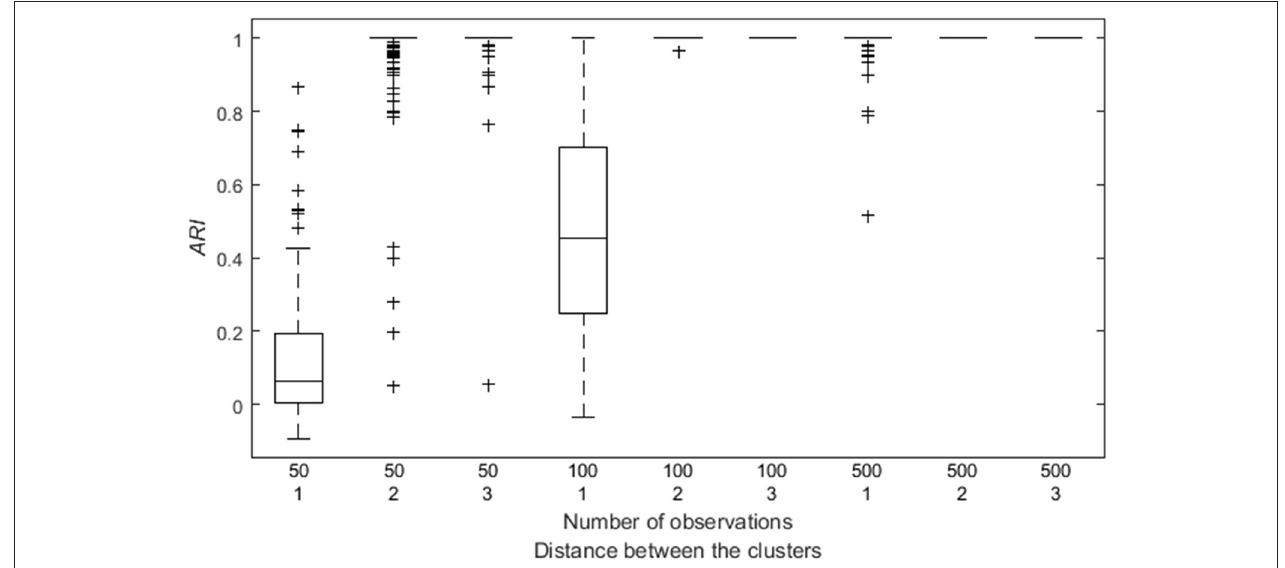
FIGURE 4 | Box plot of the ARI as a function of both the number of observations and the distance between the